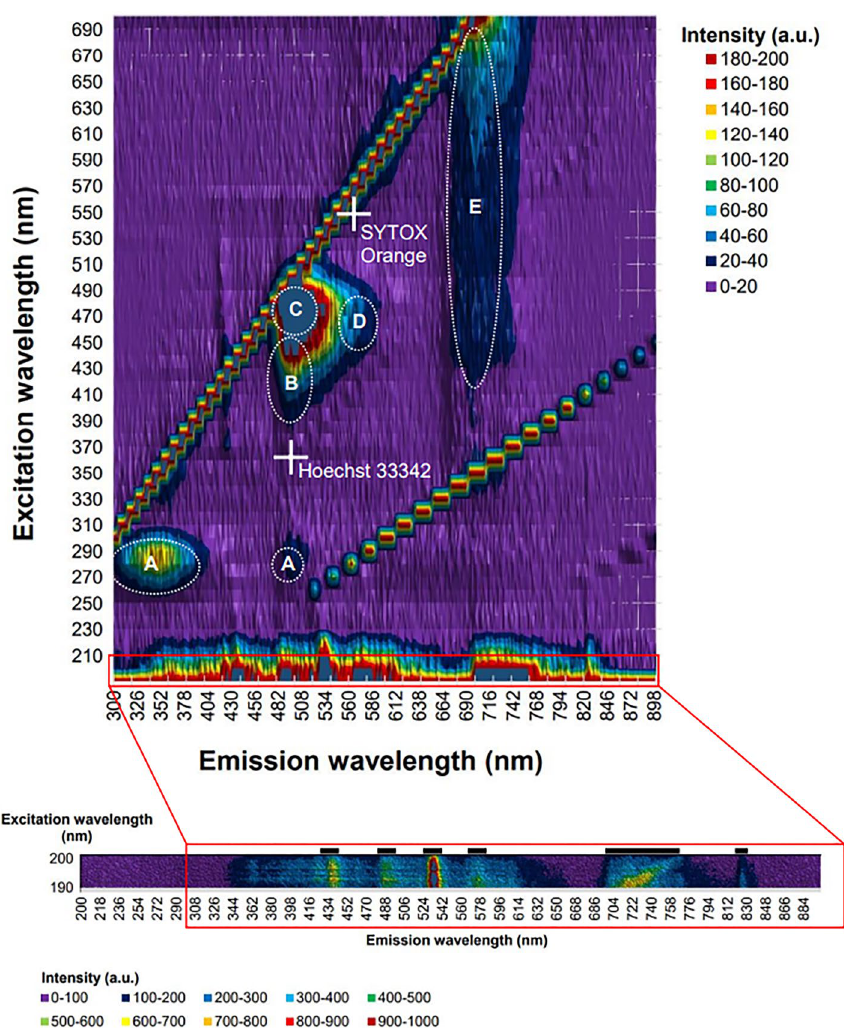
fluorescent protein ( C ), red fluorescent protein ( D ) and chlorophyll ( E ). Insert shows high resolution fluorescence matrix under deep UV excitation (190 to 200 nm), which also contains the same five emission peaks. Note the chlorophyll fluorescence presents a wide emission band from ~ 700 nm, which is well documented 61 . White crosses represent excitation and emission wavelengths of the dye pair used for membrane integrity assessment (SYTOX Orange and Hoechst